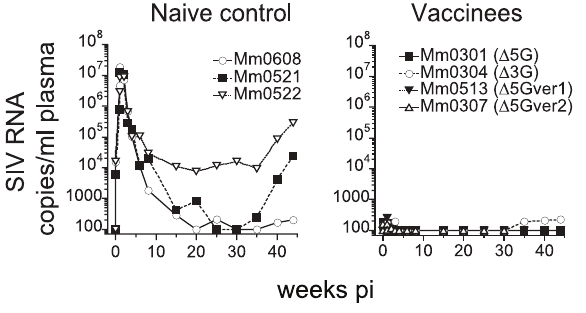
Figure 3. Plasma viral RNA loads in the homologous SIV- mac239 challenge. Three naı¨ve rhesus macaques (Mm0608, Mm0521, Mm0522) and 4 vaccinees (Mm0301, Mm0304, Mm0513, Mm0307), i.e. one animal from 4 deglycosylated SIV infection groups, were challenged intravenously with 1000 TCID 50 of SIVmac239. Plasma viral loads were determined by real-time RT-PCR with SIVmac239 primers and probe set.